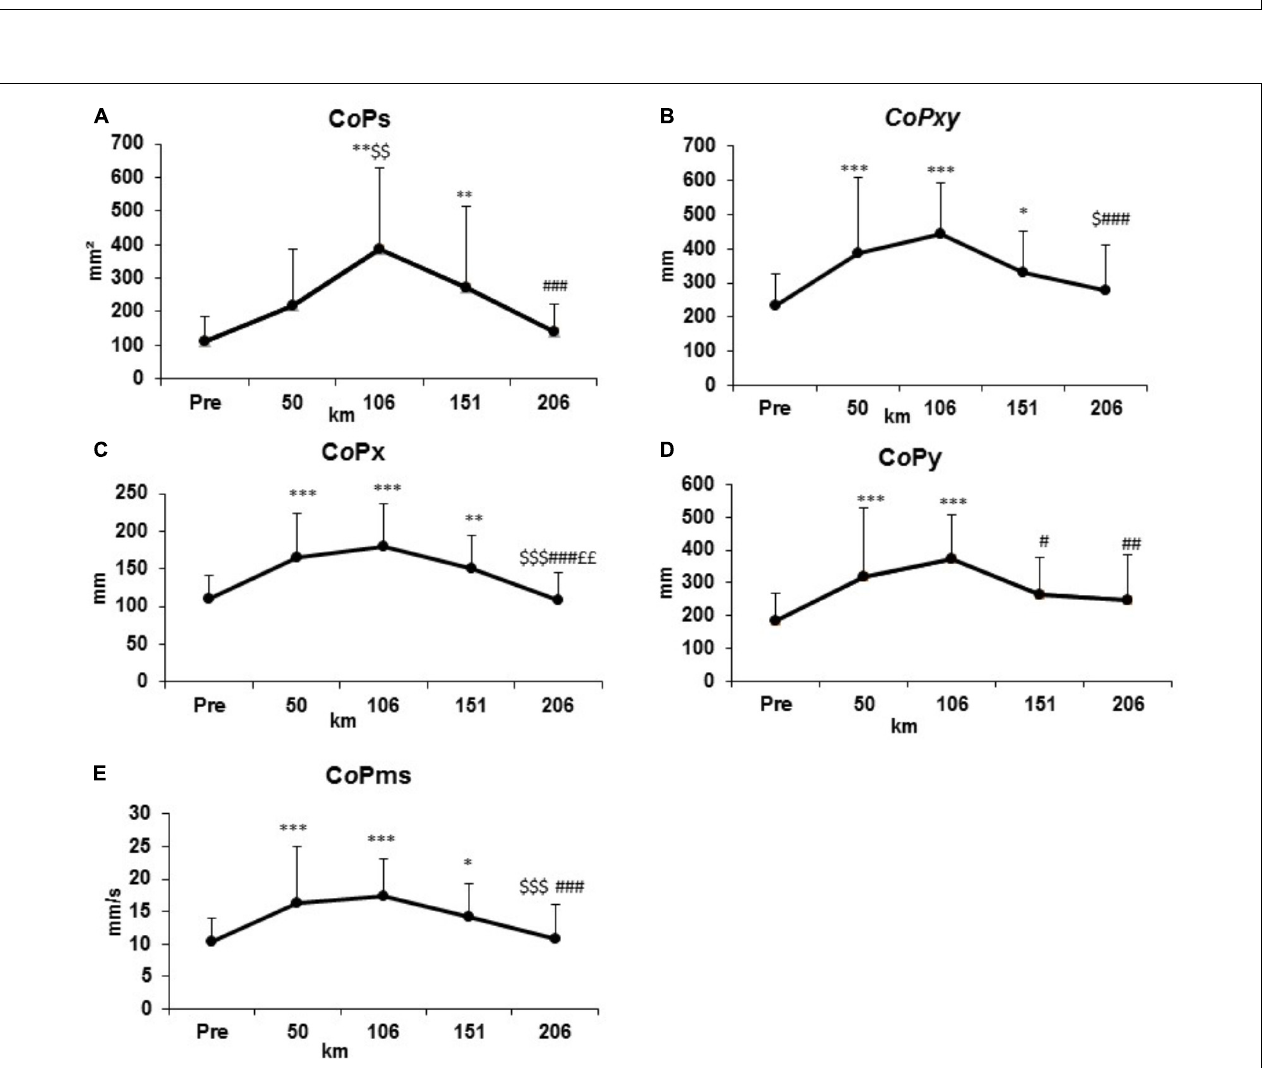
FIGURE 2 | Evolutions of standard postural control parameters represented by surface (C o Ps, A ), total displacement (C o Pxy, B ), ML displacement (C o Px, D ), AP displacement (C o Py, C ), mean speed (C o Pms, E ) at the condition PRE and every 50 km.